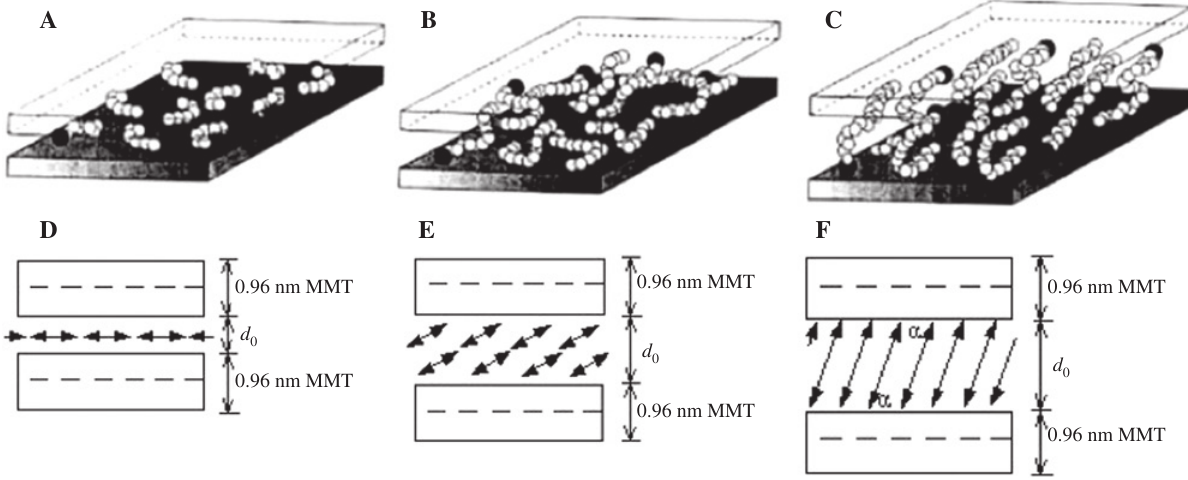
Figure 1 Arrangement of LACQAS cations in MMT layers. (A) Short alkyl chain, (B) intermediate alkyl chain, (C) long alkyl chain, (D) lateral layer, (E) half-paraffin-type molecular structure, and (F) is the actual distance between two MMT layers and 0.96 nm is the thickness of an MMT paraffin-type molecular structure, where d 0